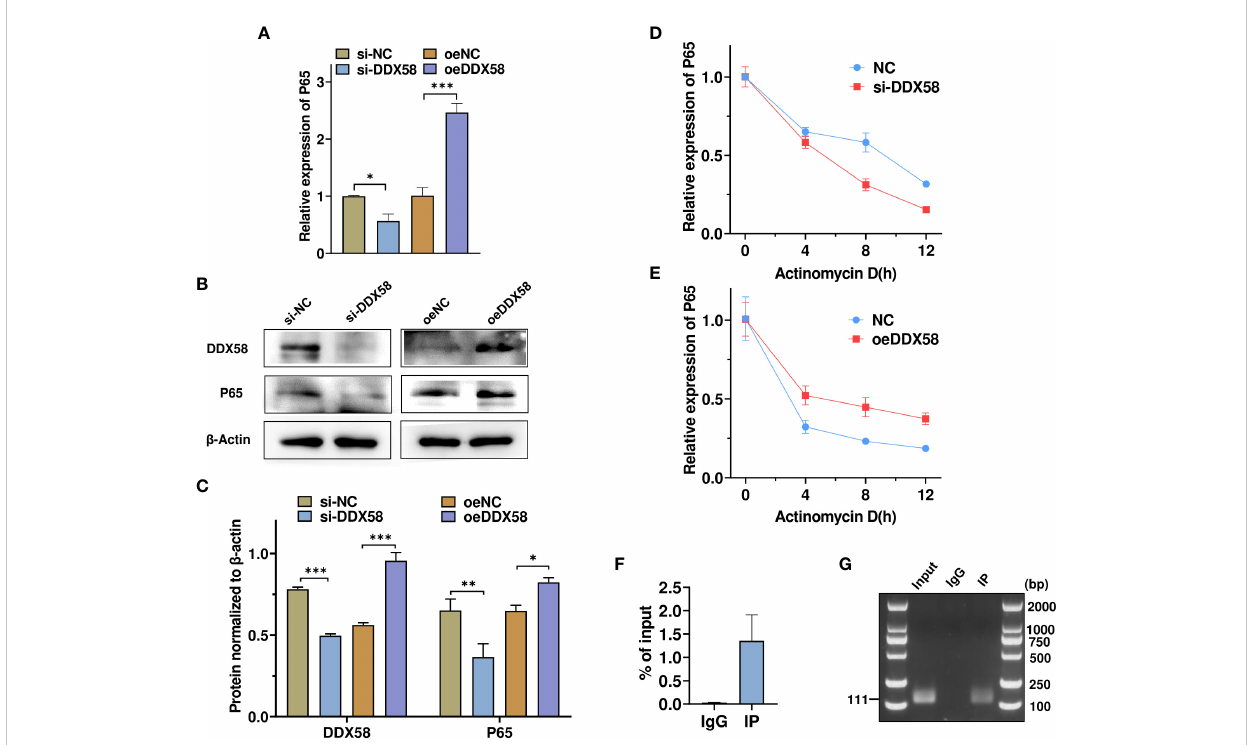
FIGURE 7 DDX58 promotes p65 expression by stabilizing p65 mRNA. (A) RT – qPCR was used to detect changes in p65 mRNA expression after DDX58 overexpression and DDX58 knockdown. * p < 0.05, *** p < 0.001. vs . the corresponding control. (B, C) Western blot and grayscale analyses revealed the expression of DDX58 and p65 protein in (A) . (D, E) Cells were treated as described in (A) **p < 0.01. and were then exposed to Actinomycin D for 0, 4, 8, and 12 h. p65 mRNA expression was detected using RT – qPCR. * p < 0.05. vs . the corresponding control. (F) RNA-binding protein immunoprecipitation PCR was used to analyze the interaction between DDX58 protein and p65 mRNA. (G) Agarose electrophoresis was used to detect the PCR products from (F)